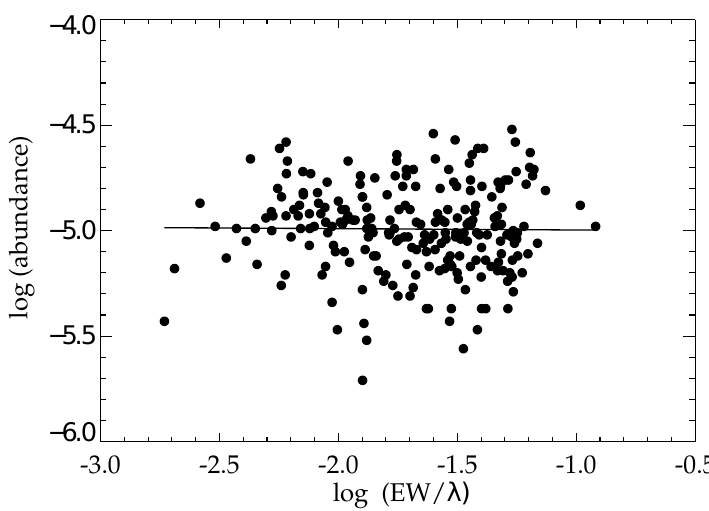
Fig. 1. Dependence of the iron abundance on Fe I line strengths. The plot is made for a microturbulent velocity of 4.0 km s − 1 . With this microturbulent velocity the iron abundance from Fe I lines is log " (Fe) = 7.00 (cid:6) 0.21. The number of useful Fe II lines is much smaller, and the determina- tion of the microturbulent velocity is less accurate. Using quite numerous lines of Ni I we found (cid:24) t = 4.3 km s − 1 . The comparison of this value was used to estimate the error of (cid:24) t stated above. With the same (cid:24) t = 4.0 km s − 1 the iron abundance from Fe II lines is log " (Fe) = 7 : 15 (cid:6) 0 : 26. This shows that the assumed